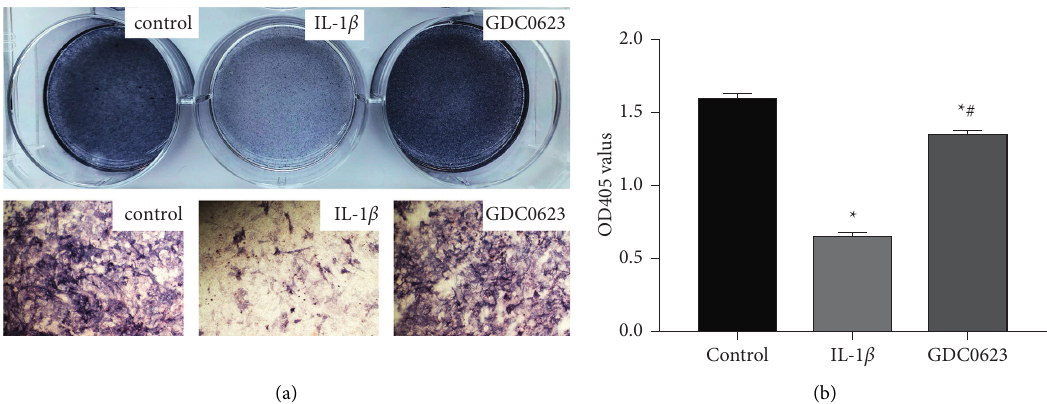
Figure 2: Comparisons of ALP staining and activities among the control, IL-1 β , and GDC0623 groups. (a) Osteoblasts were stained for ALP levels after being induced with an osteogenic differentiation medium for 7 days (upper lane). Details of ALP staining at day 7 (lower lane). (b) ALP activities were detected after cell induction for 7 days. Data are expressed as mean ± SD for n � 3. ∗ p < 0.05 versus the control group; # p < 0.05 versus the IL-1 β